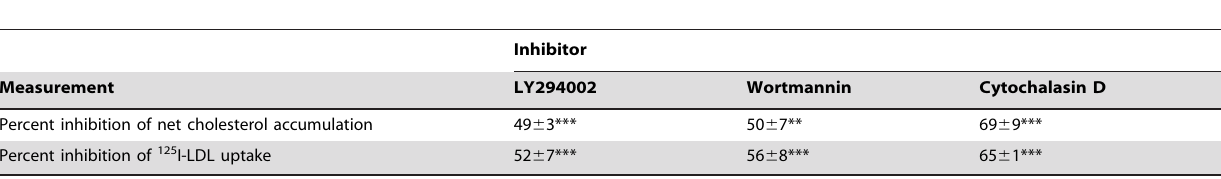
Table 1. The effect of PI3K inhibitors and cytochalasin D on LDL uptake and net cholesterol accumulation in LDLR 2 / 2